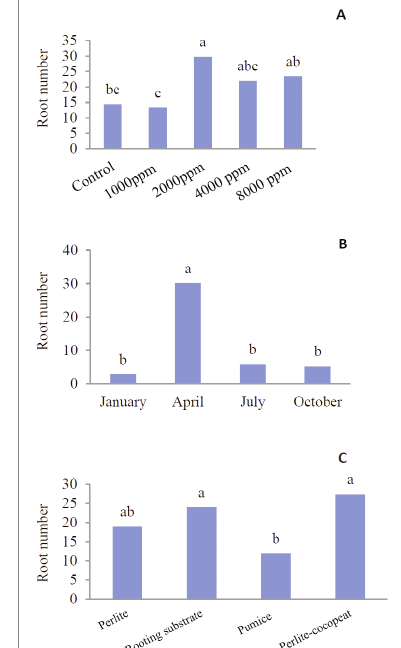
Fig. 6 ­ The mean values of rooting performance in rooted cut­ tings (percentage of rooting) within substrates and for the 5 treatments of indole butyric acid. The mean values with the same letter were not different at level 0.05 according to the LSD test. Sample data: 540 cuttings for each substrate.